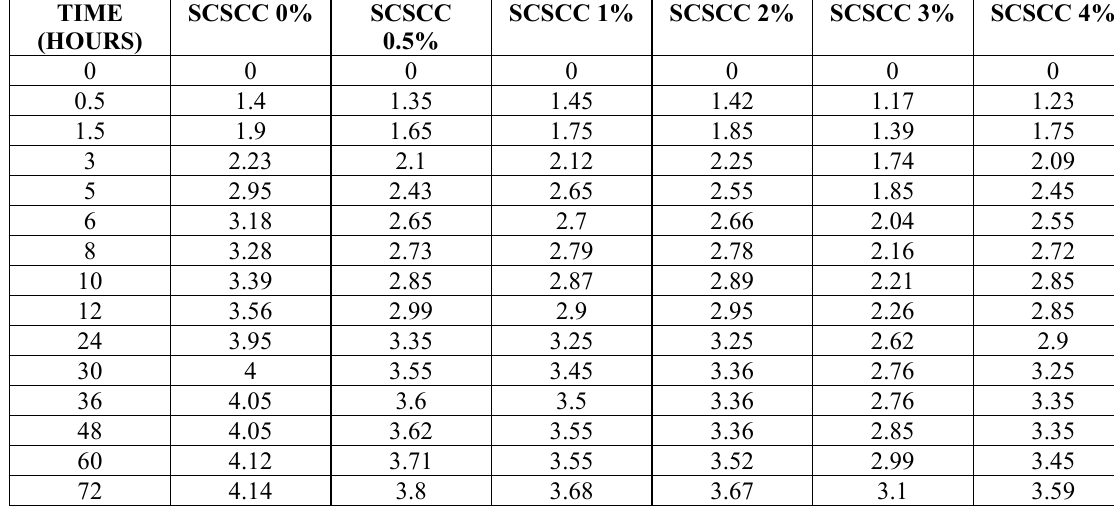
Percentage of Absorption values of PEG 400. TIME